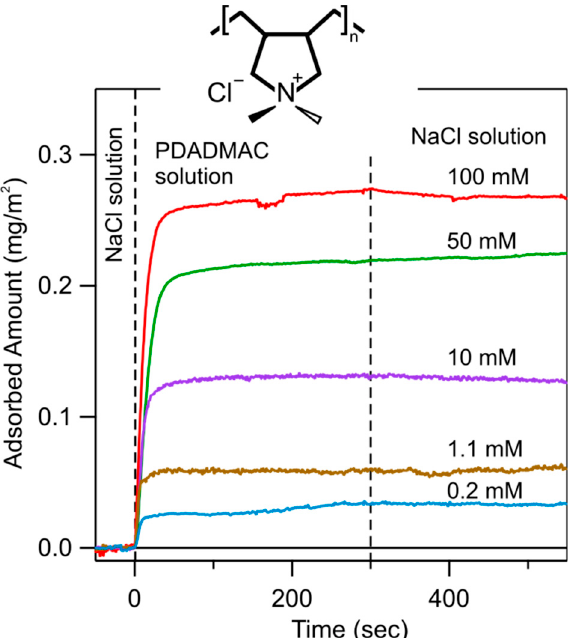
Figure 2. Time-dependence of the adsorbed mass of PDADMAC on the silica surface determined by optical reflectivity measurements at a polyelectrolyte concentration of 5.0 mg/L and pH 4.0. The ionic strength was varied for the different runs as indicated. The dashed lines indicate where substrate was flushed with a NaCl solution, then with the same solution containing PDADMAC, and finally again with the NaCl solution. The structural formula of the monomeric unit of PDADMAC is shown as inset.